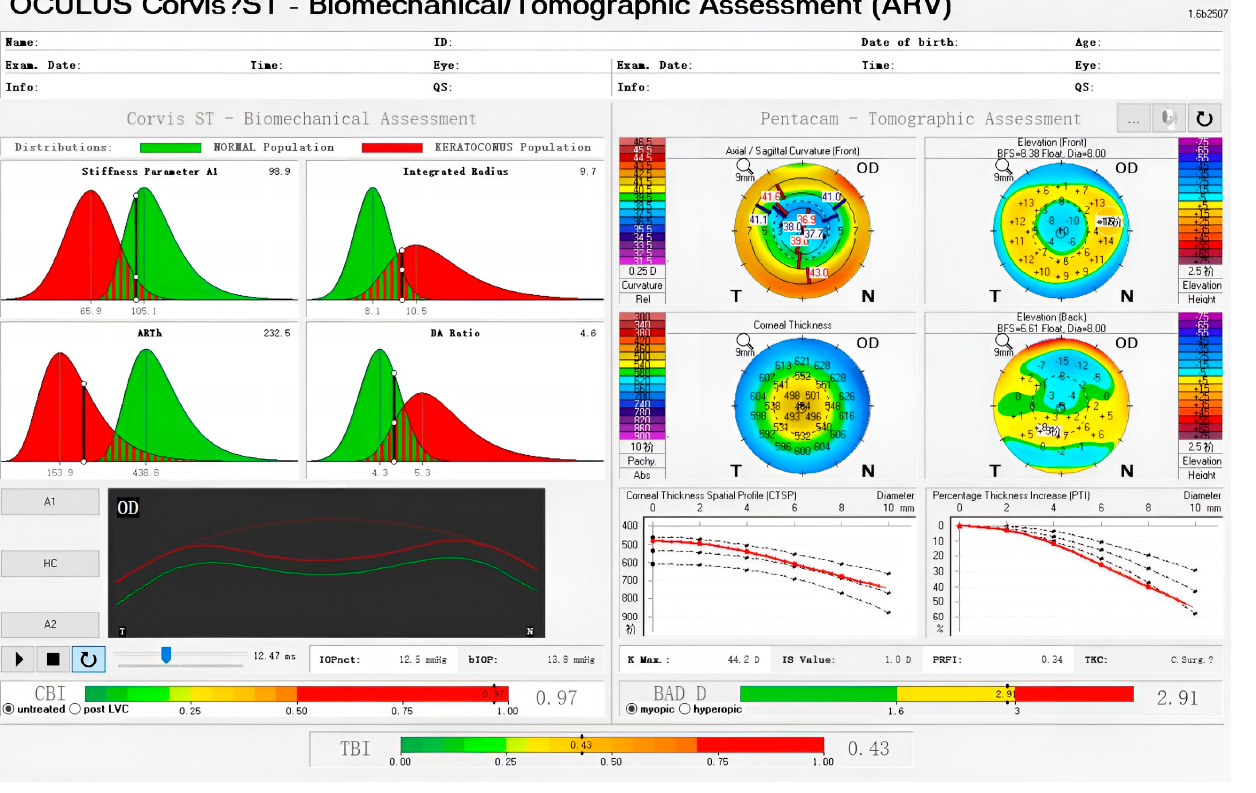
Figure 2. Example of an ectatic eye observed using Corvis ST and Pentacam. Corneal parameters are displayed in the upper left and corneal deformation morphology is displayed in the lower left. Corneal morphological data are shown on the right. The Belin − Ambrósio display ( BAD) D is a parameter based on corneal morphology to assess the risk of corneal ectasia. The corneal biomechanical index (CBI) and the total biomechanical index (TBI) are shown at the bottom.